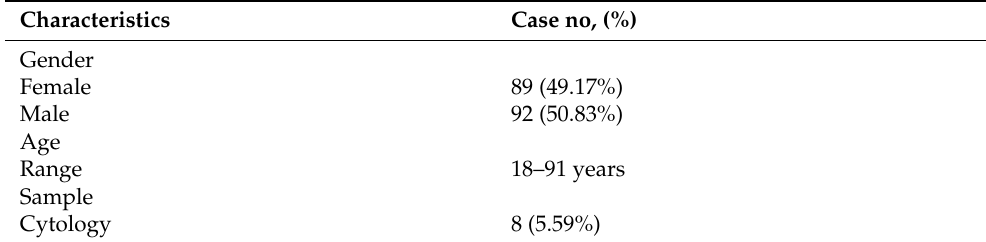
Table 1. Clinical findings according to the published cases (see Supplementary